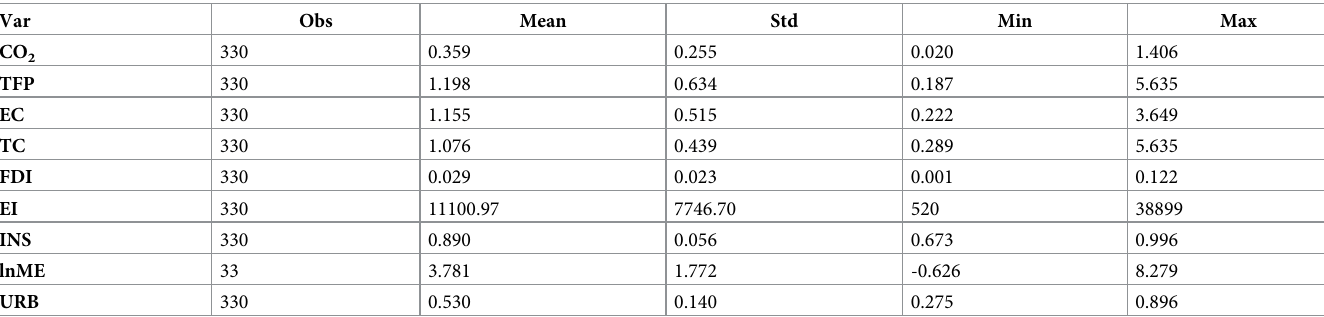
Table 3. Summary